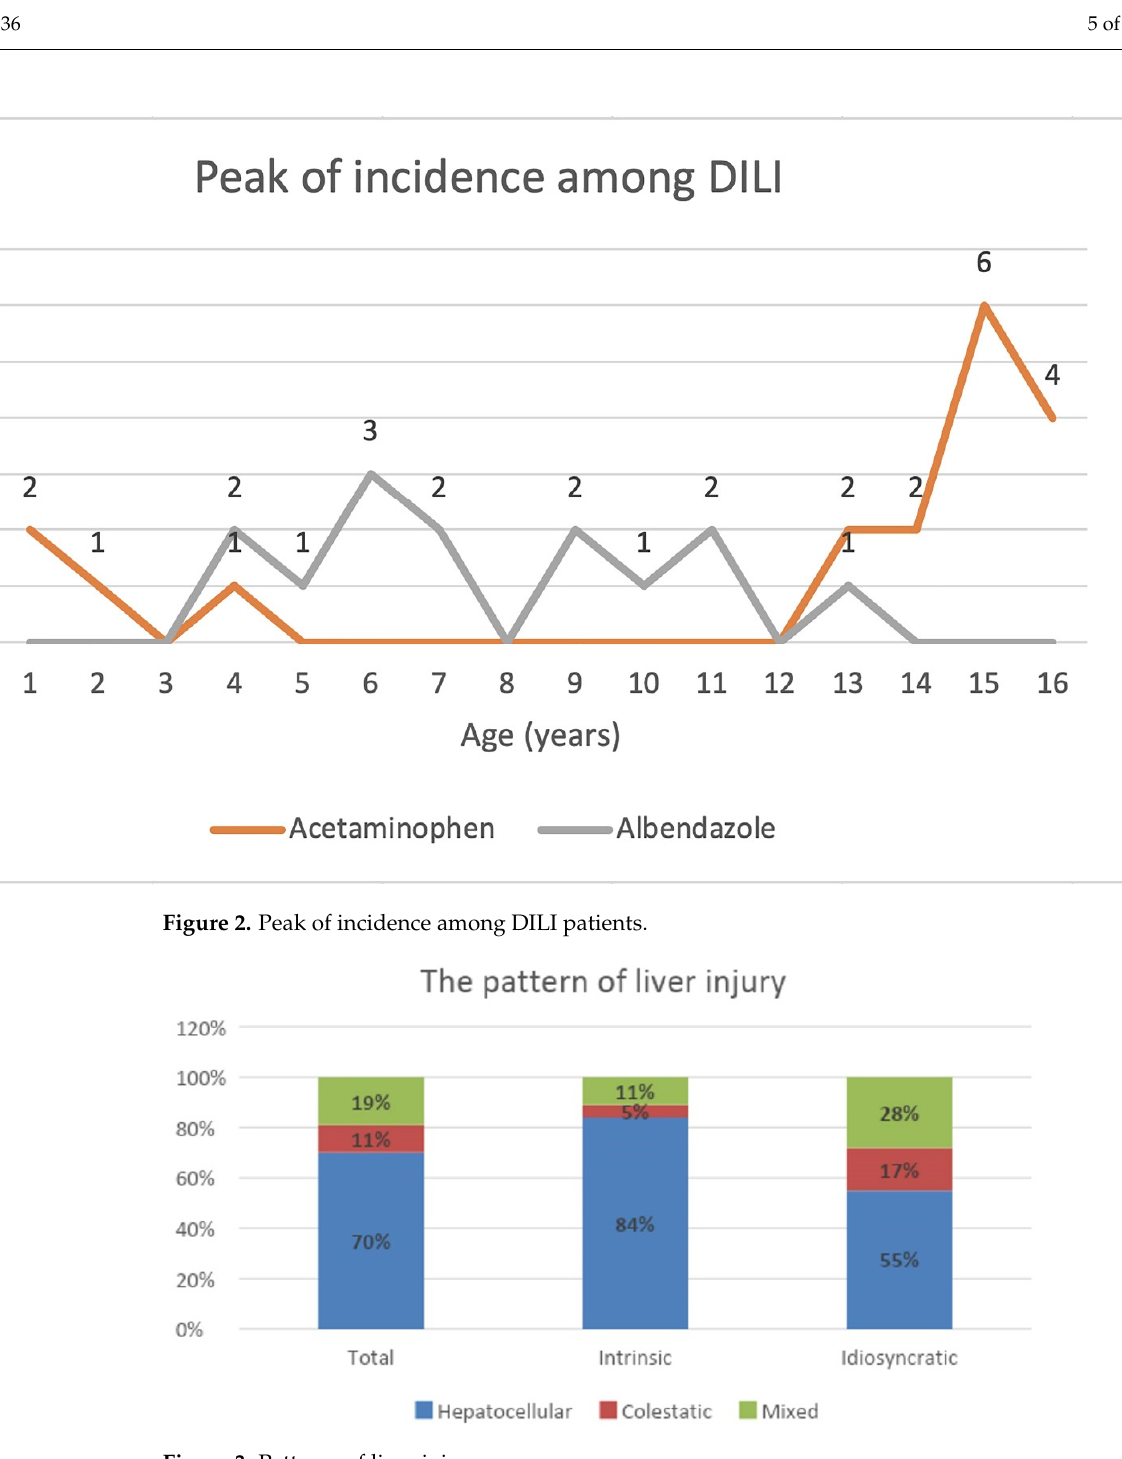
Figure 3. Patterns of liver